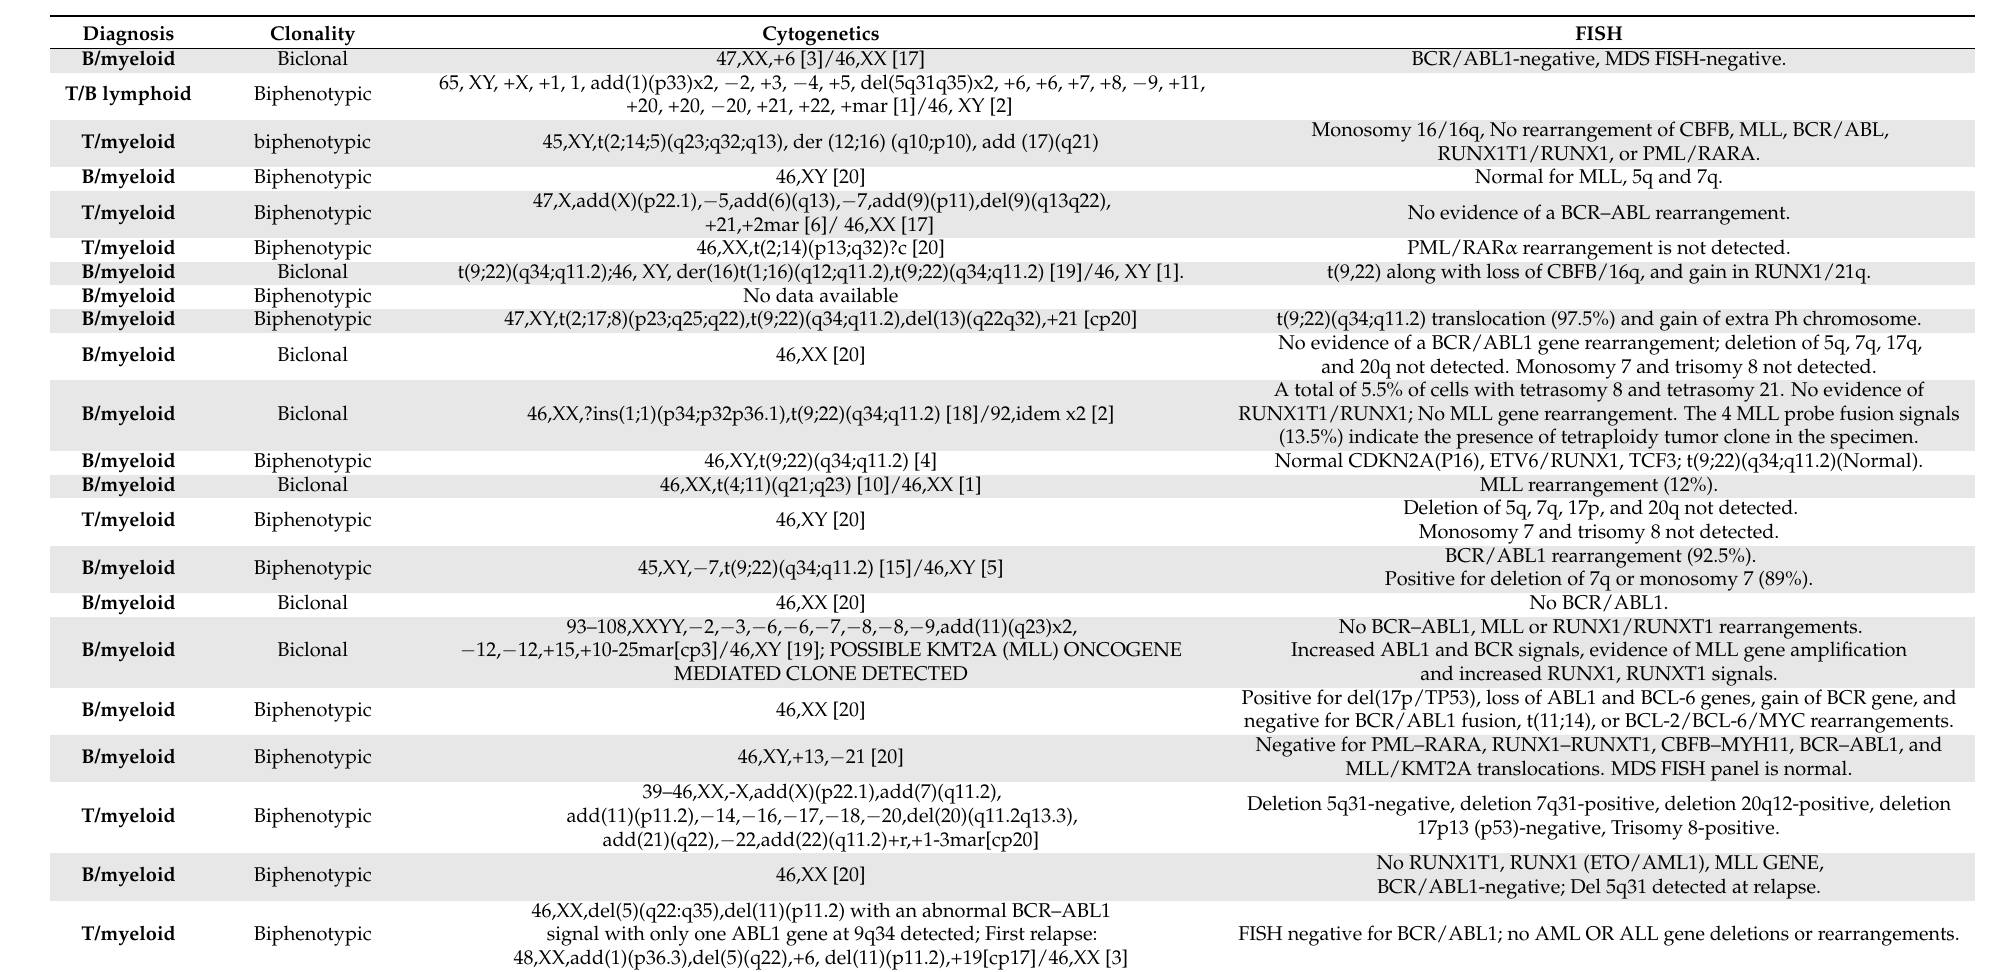
Table 1. Summary of karyotypic and fluorescence in situ hybridization (FISH)